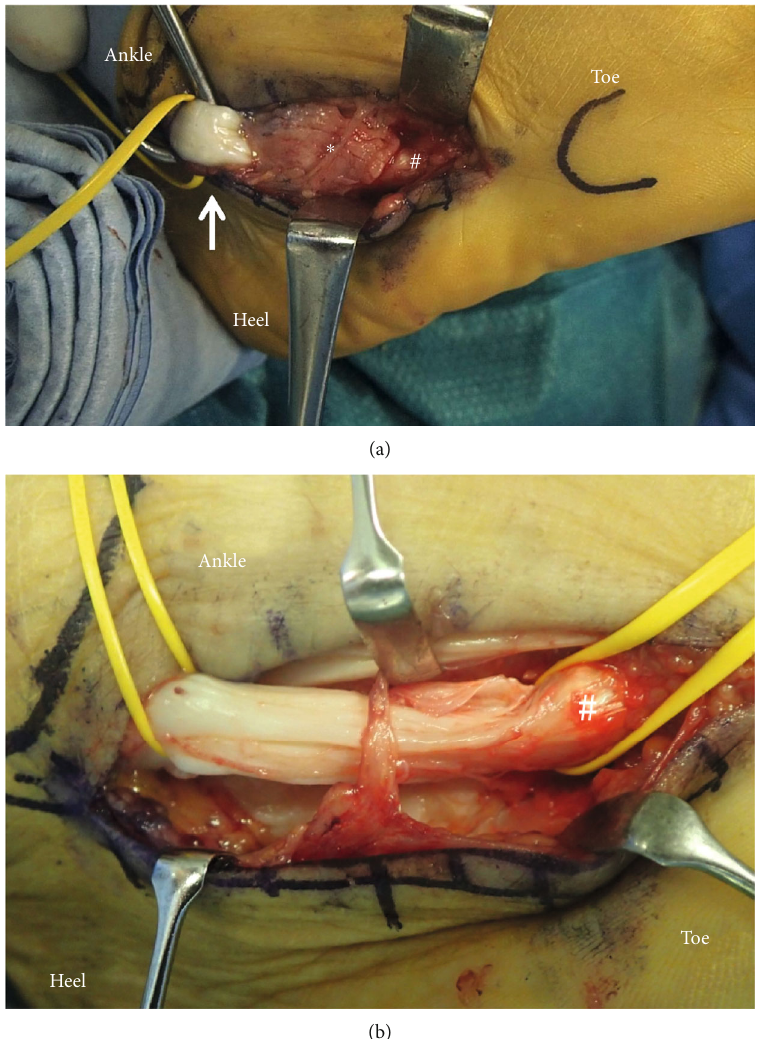
Figure 5: Intraoperative photograph: (a) peroneus longus tendon runs through hypertrophic peroneal tubercle. A traction of peroneus longus tendon causes hypertrophic peroneal tubercle and os peroneum to collide with each other. (b) Resection of hypertrophic peroneal tubercle released the impingement between os peroneum. ∗ Hypertrophic peroneal tubercle, # os